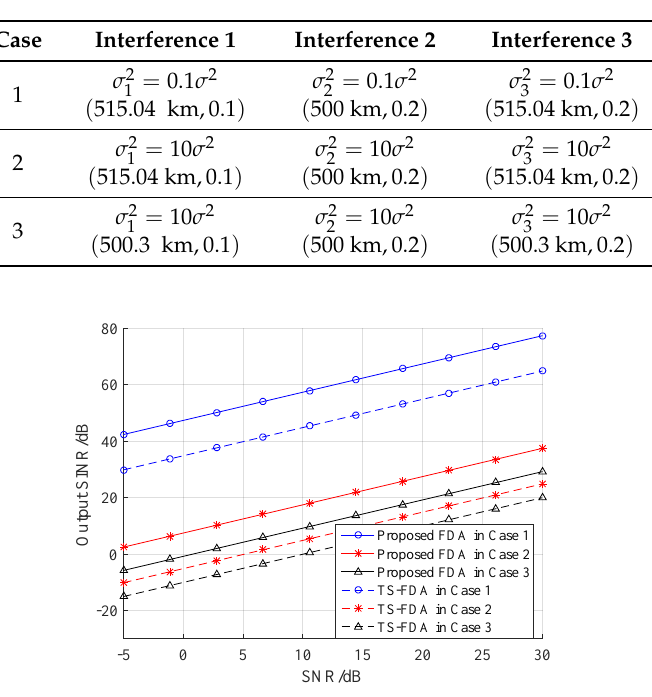
Table 2. Three cases of interference.